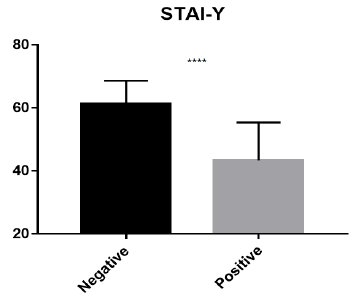
Figure A2. Results at the STAY-Y test.